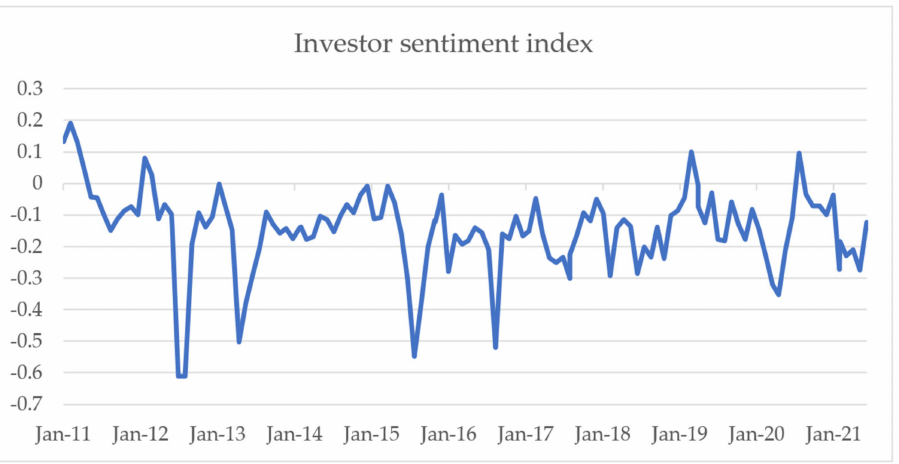
Figure 2. Trends of investor sentiment index. The data span from January 2011 to June